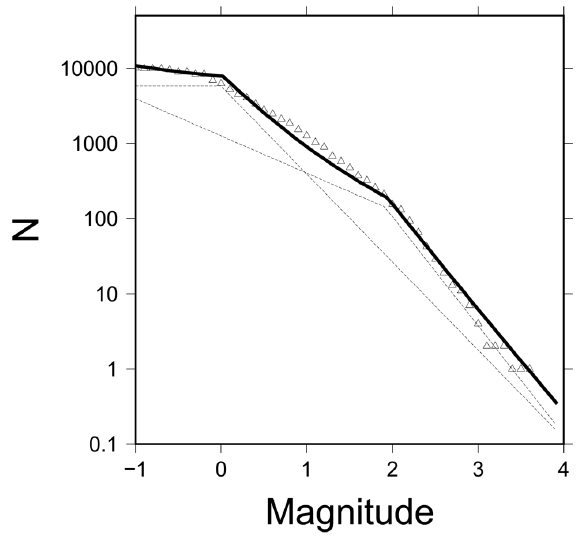
Figure 4. Gutenberg-Richter relationship for the BKE catalogue. Triangles are the experimental data. The dashed lines represent the two theoretical distributions while the solid line is their sum (see Section 2 for details). The b-value of the first distribution is b = = 0.0 ± 0.12. For the second distribution b = 1.17 ± 0.06 while M c 1.45 ± 0.25 and M = 1:91 _ c